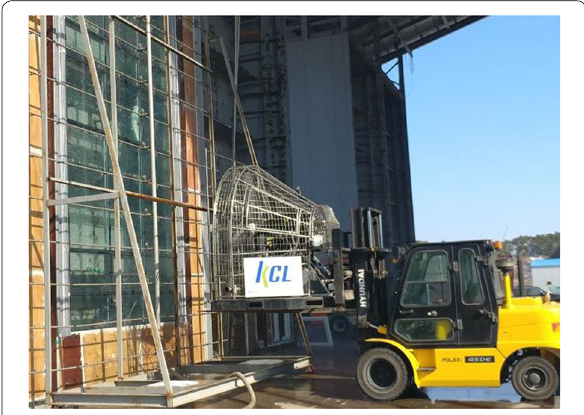
Fig. 9 Air/water tightness performance test.